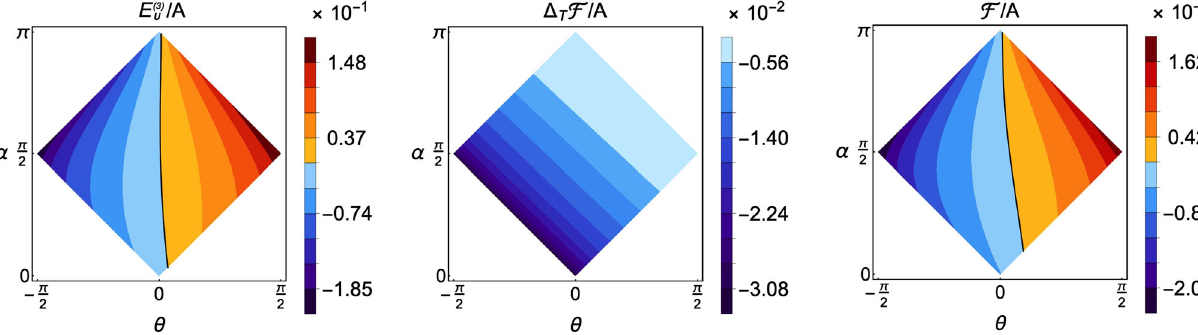
Fig. 3 Quantum vacuum energy per unit area at T = 0 (left), thermal correction Δ T F / A (center) and total Helmholtz free energy per unit area (right) as functions of the parameters α and θ . In these plots, T = 0 . 55 , n 1 = 1 and L = 1